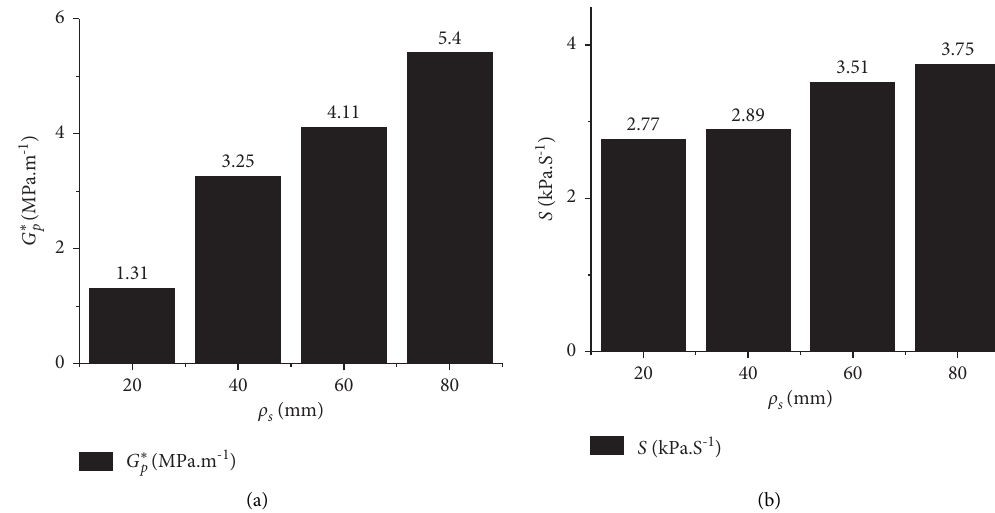
Figure 7: Hysteresis parameters of different concentrations. (a) Maximum hysteresis. (b) Hysteresis area.